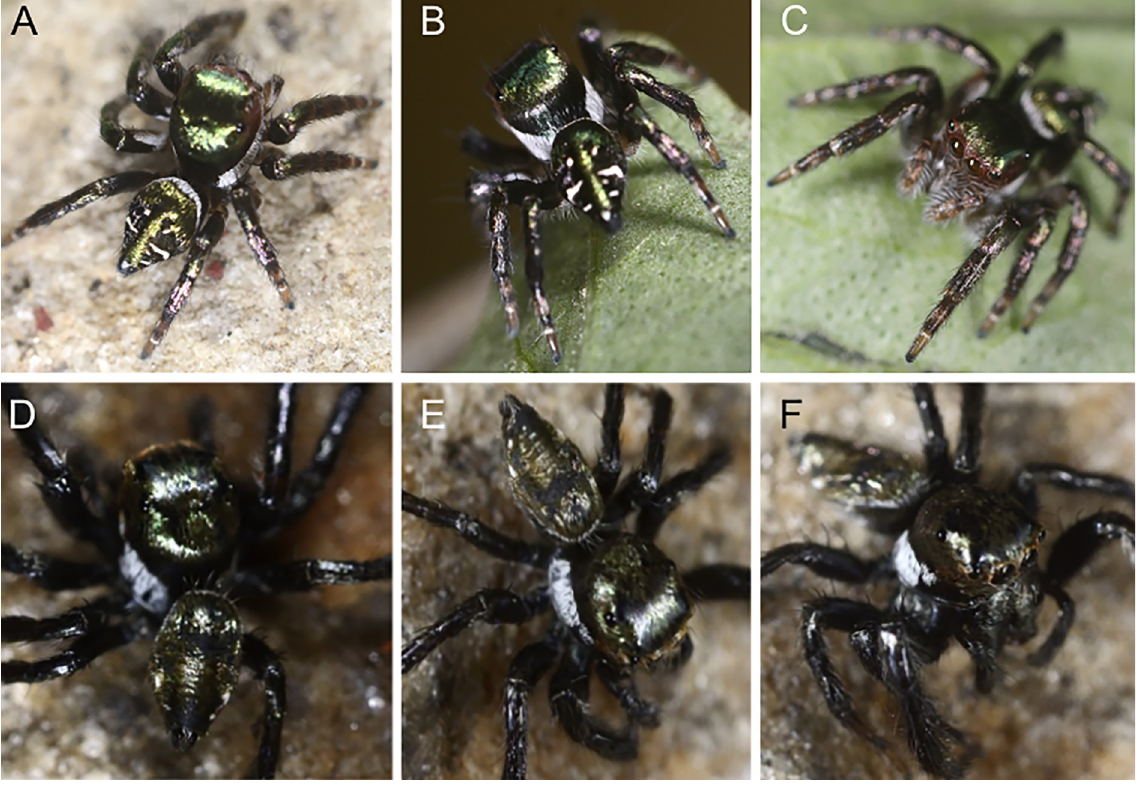
Fig 10 . Photographs of live Carrhotus silanthi Caleb, 2020, males. A – C . From Giants Tank Sanctuary. D – F . From